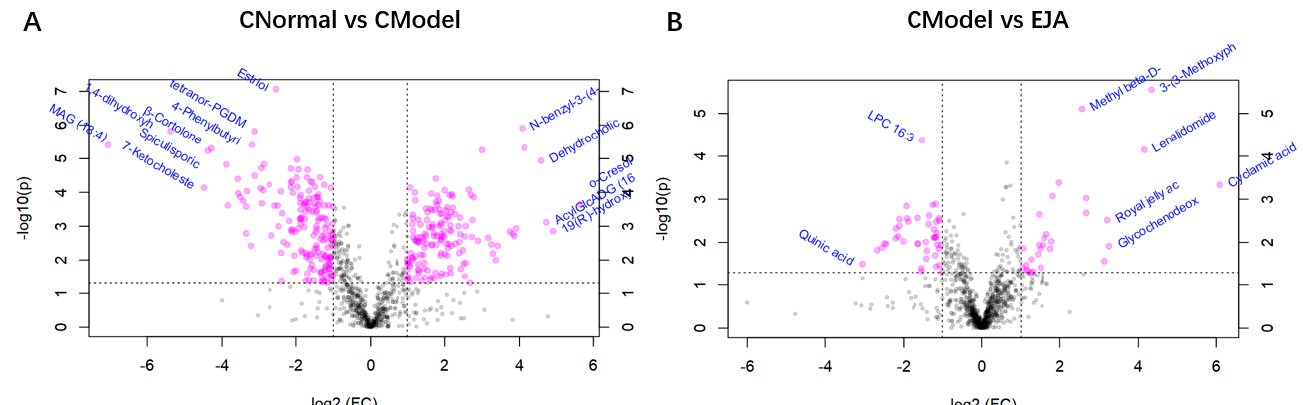
Figure 6. Volcano plot of multiplier variation. ( A ) Volcano plot of change in the difference between control and model groups; ( B ) Volcano plot of the difference between the model group and the drug administration group. Note: Horizontal coordinates are multiples of change, vertical coordinates are t-test p -values.